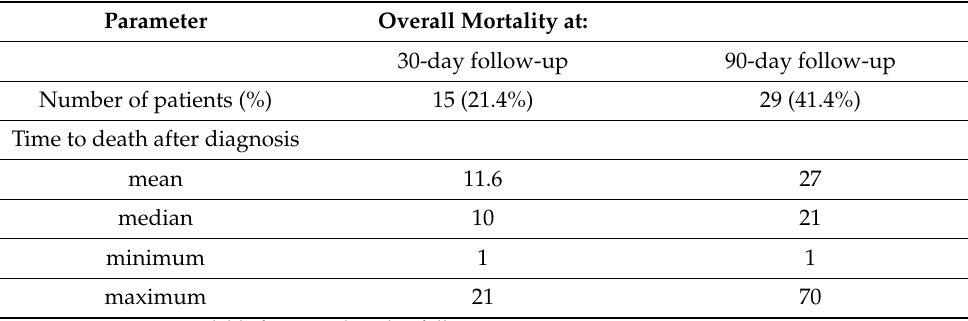
Table 1. Overall mortality within 30 or 90 days of diagnosis of CDI.